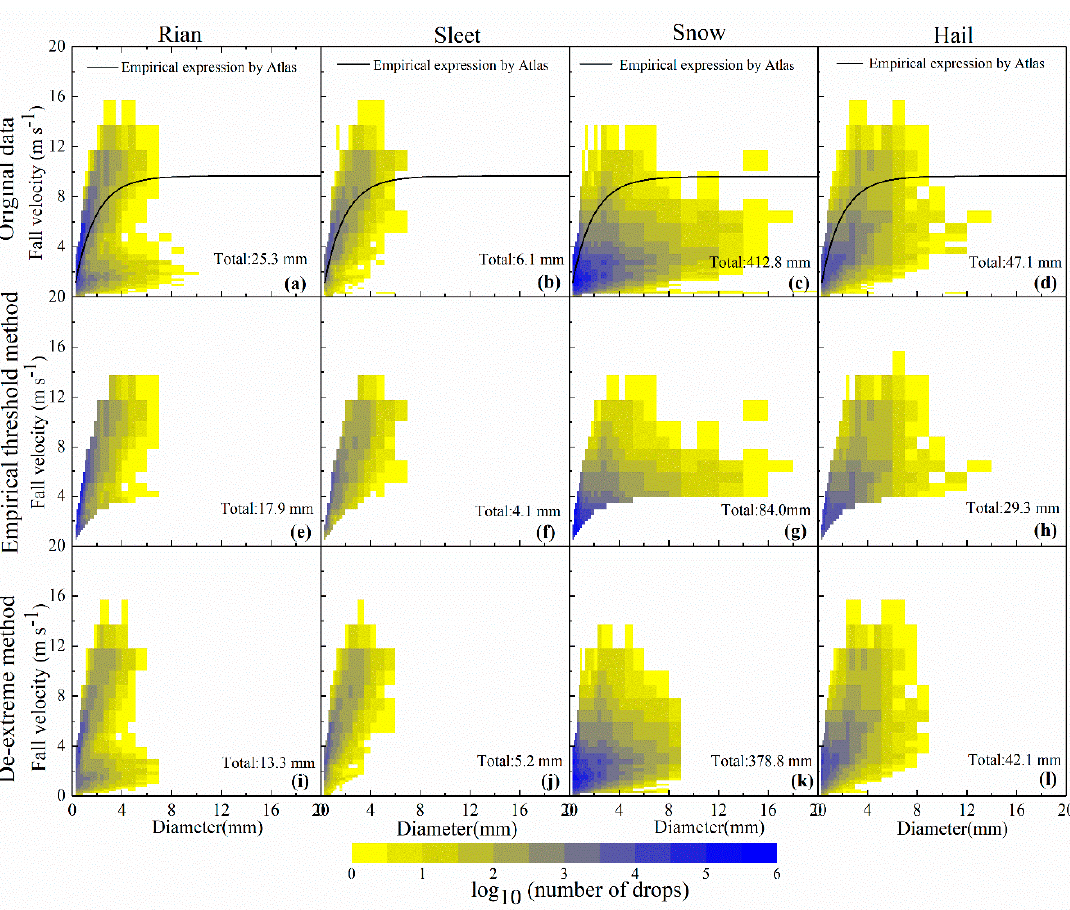
Figure 3. Characteristics of the raindrop size distribution (DSD) for di ff erent types of precipitation and the application of di ff erent data quality control schemes to precipitation at Tanggula. ( a – d ) DSD of rain, sleet, snow, and hail using the original data. ( e – h ) DSD of rain, sleet, snow, and hail using the empirical threshold method. ( i – l ) DSD of rain, sleet, snow, and hail using the de-extreme method. The V–D relationship is the empirical fall velocity–diameter relationship of Atlas et al. [37].